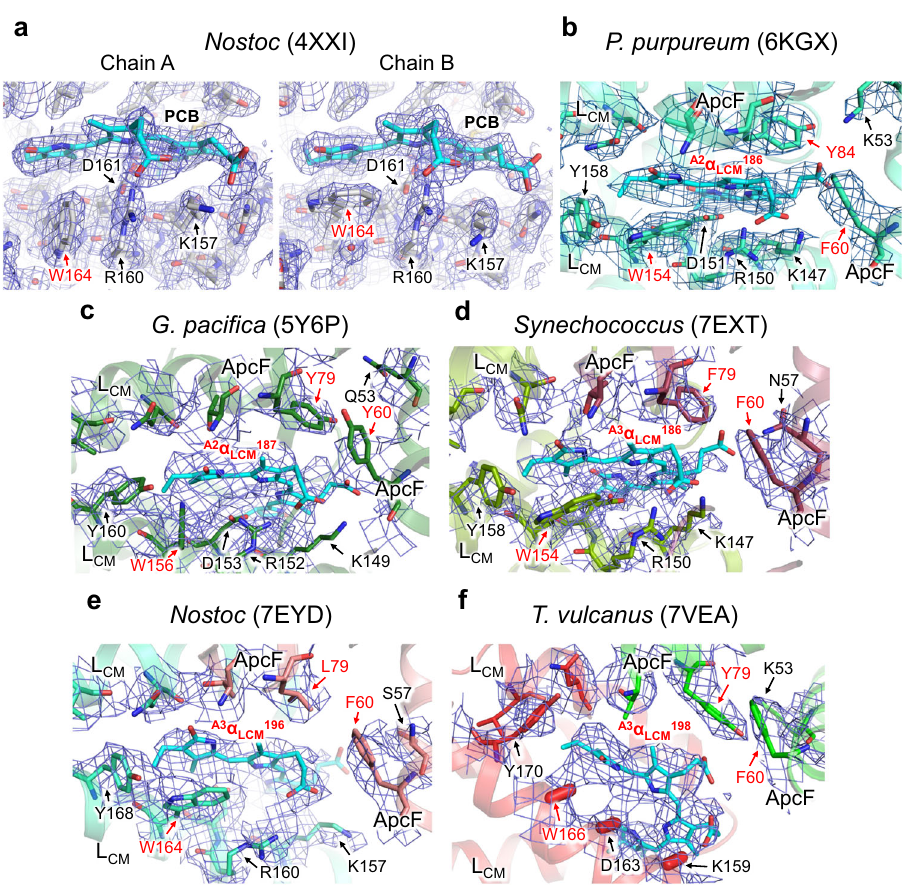
Fig. 5 Comparison of chromophores and their surrounding structures in the terminal emitters (ApcE [L CM ]) of each species. a Crystal structure of Nostoc 7120 ApcE at 2.2 Å resolution. b Cryo-EM structure of the red algal P. purpureum ApcE at 2.8 Å resolution. c Cryo-EM structure of the red algal G. paci fi ca ApcE at 3.5 Å resolution. d Cryo-EM structure of the cyanobacterial Synechococcus 7002 ApcE at 3.5 Å resolution. e Cryo-EM structure of the cyanobacterial Nostoc ApcE at 3.9 Å resolution. f Cryo-EM structure of the cyanobacterial T. vulcanus ApcE at 3.7 Å resolution. These ApcE structures were superimposed with their density map contoured at 1 σ ( a ), 3 σ ( b ), 2 σ ( c ), 5 σ ( d ), 3 σ ( e ), and 3 σ ( f ). Amino acid residues for which the side-chain arrangement cannot be precisely displayed are indicated with capsule-shaped objects. The directions of atoms from C α to C β in the residues are indicated by the capsule-shaped objects.